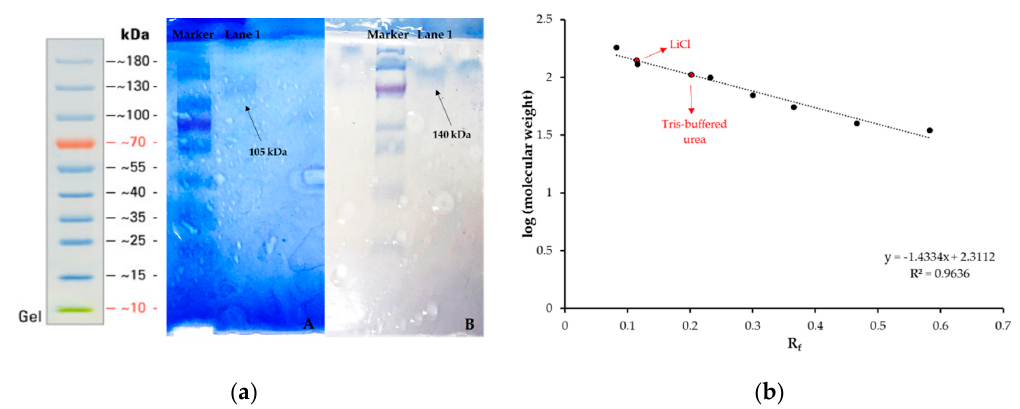
Figure 2. Surface protein characterization results: ( a ) SDS-PAGE and ( b ) R f value.